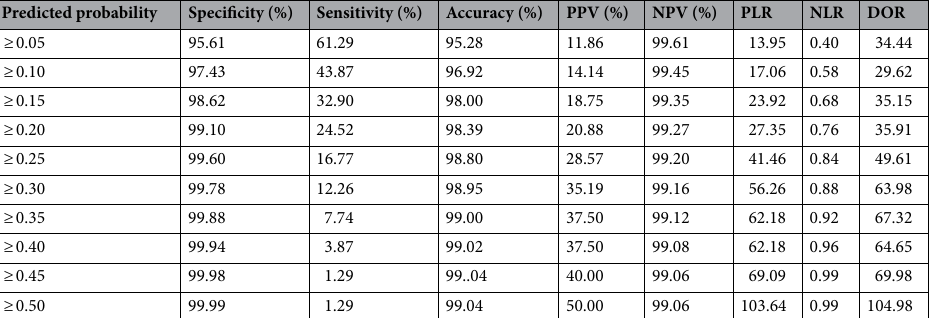
Table 5. Values of sensitivity, specificity and predictive values of the nomogram scores at different cut-off values. PPV, Positive predictive value; NPV, Negative predictive value; PLR, Positive likelihood ratio; NLR, Negative likelihood ratio; DOR, Diagnostic odds